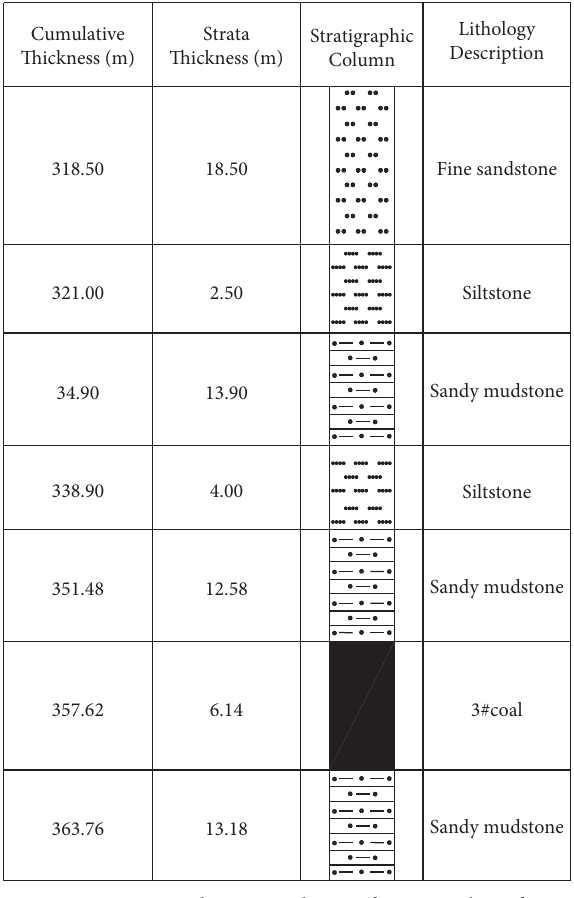
Figure 14: Comprehensive Column of 4309 working face. Table 2: Occurrence of joints with different parameters in coal